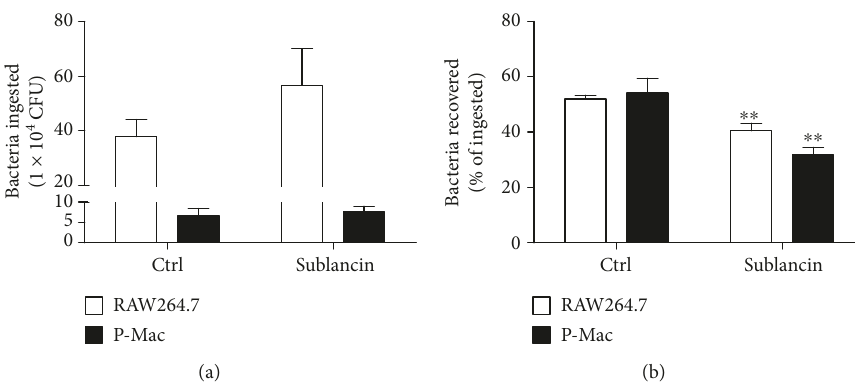
Figure 2: The antimicrobial peptide sublancin promoted the capacity of RAW264.7 macrophages and mouse peritoneal macrophages (P-Mac) to kill Staphylococcus aureus ATCC43300. RAW264.7 macrophages and P-Mac were cultured 12 hours with or without sublancin (25 μ M) and then exposed to ATCC43300 (MOI 20). Phagocytosis (a) and killing (b) of bacteria were quanti fi ed as described in Materials and Methods. Data are presented as mean ± SEM ( n = 6 ). Signi fi cant di ff erence with control cells was designated as ∗∗ P < 0 01 .